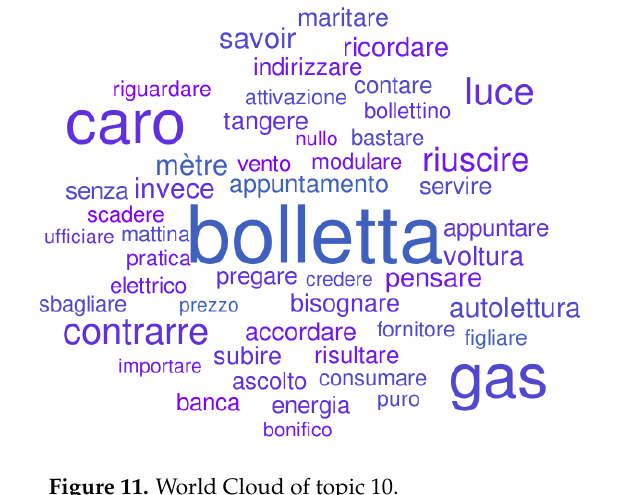
Figure 11. World Cloud of topic 10.